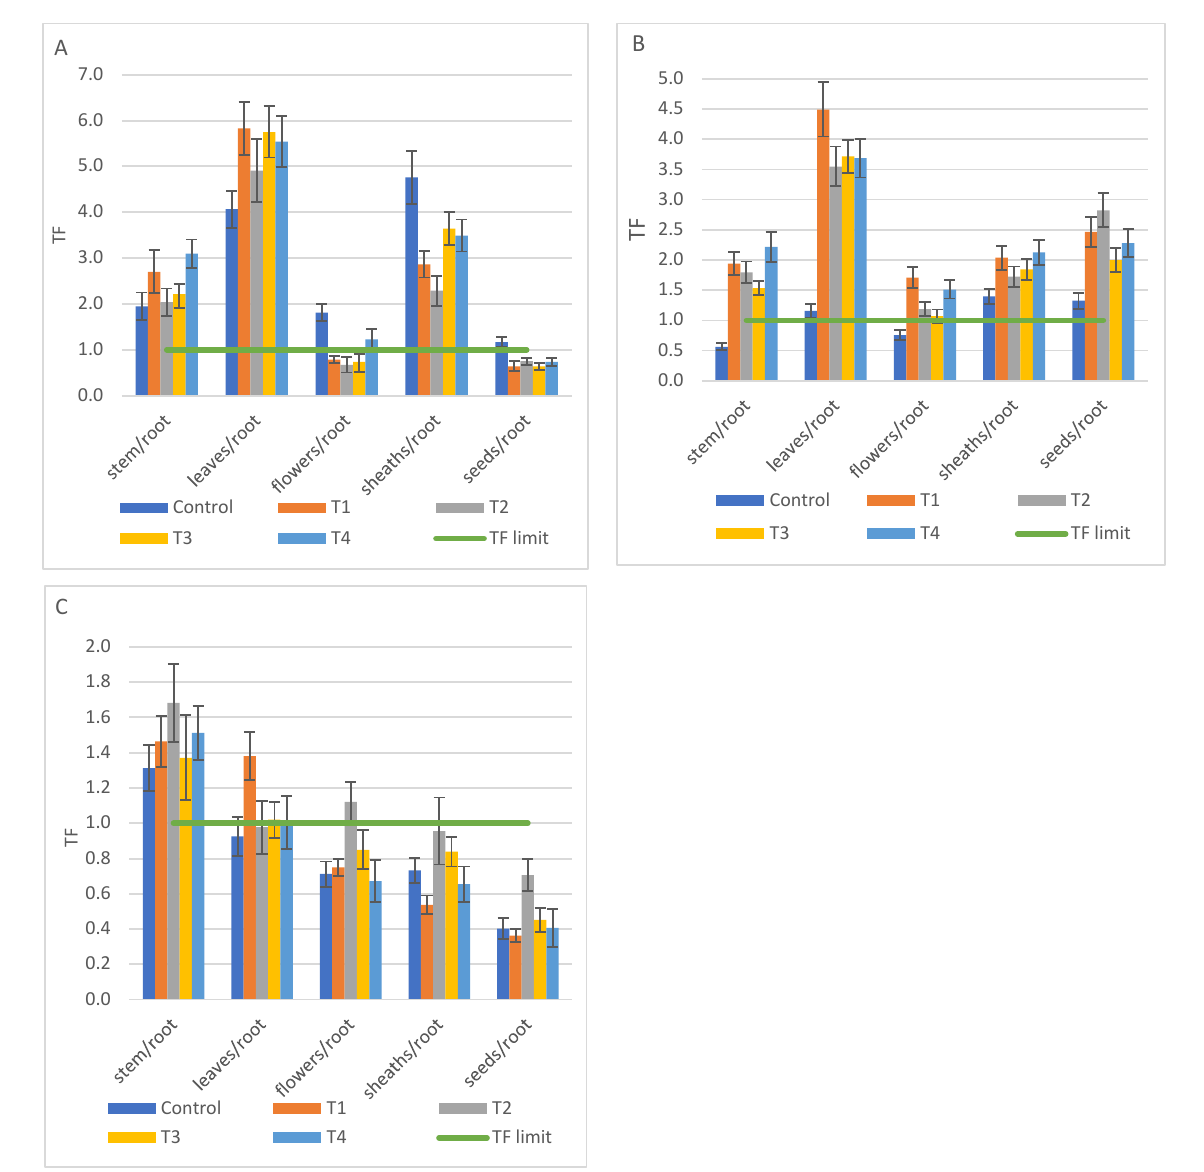
Figure 7. The translocation factor (TF) from root of S. alba to plant tissues in T1 to T4 treatments compared to control and TF limit (average ± SD, n = 6) for macro nutrients: ( A ) Ca; ( B ) Mg; ( C ) K.